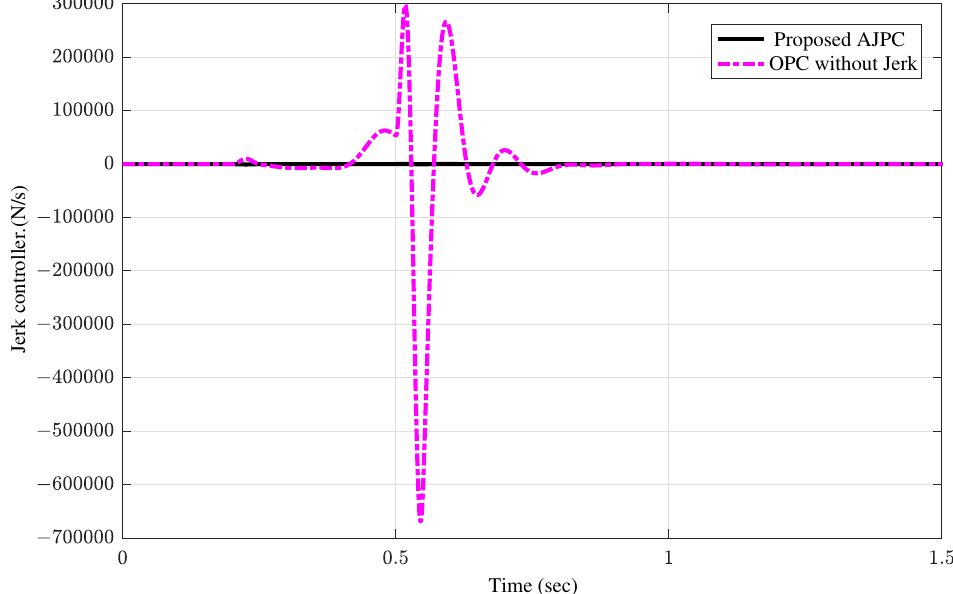
Figure 8. Time domain response of control jerk to a bump velocity input using proposed AJPC strategy and OPC strategy without